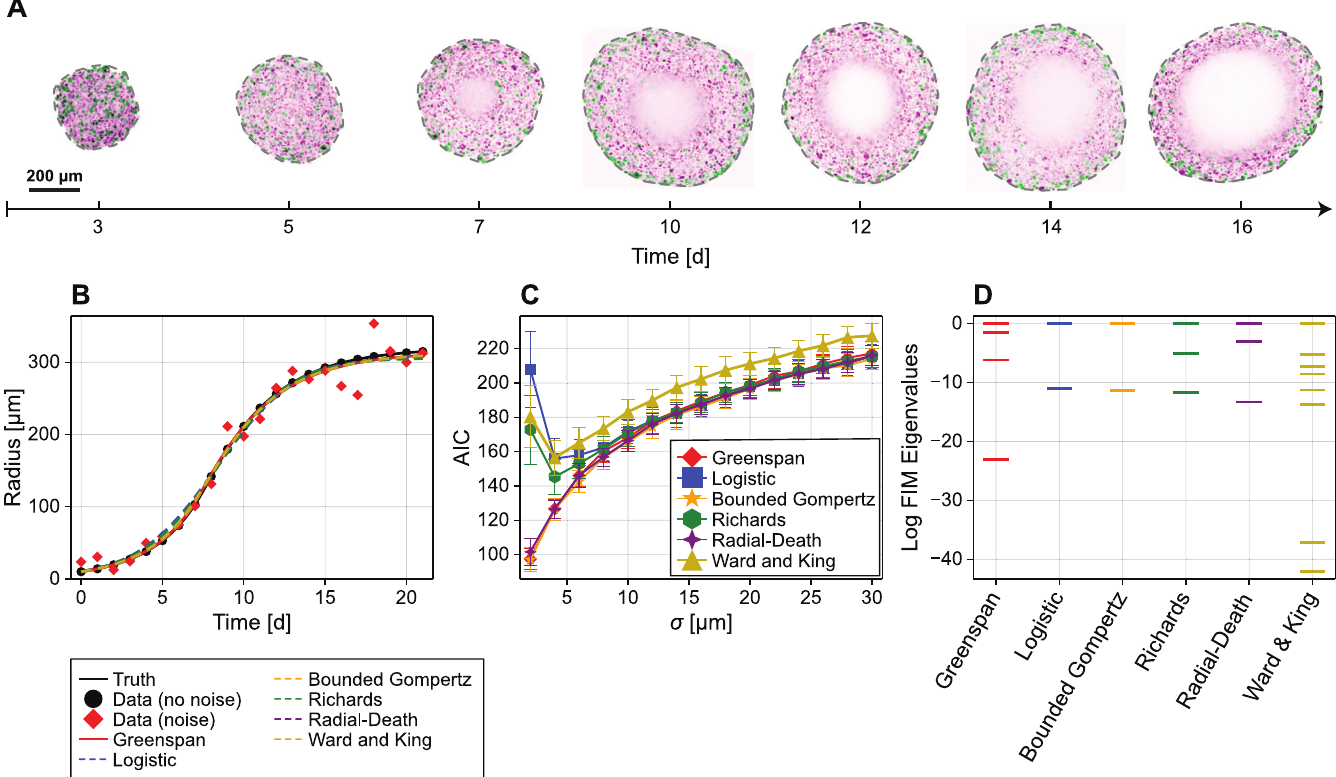
Fig 1. Mathematical models of tumour spheroid growth. (A) Microscopy images from tumour spheroid growth experiments. Spheroids are grown from WM983b cells (a human melanoma cell line) [18], harvested, and imaged using confocal microscopy at various time points. Cells are transduced with fluorescent cell cycle indicators, showing cells in gap 1 (purple) and gap 2 (green). From day 7, a necrotic core void of living cells is evident in the spheroid centre. (B) Synthetic spheroid data generated from Greenspan’s model [13] (black discs) with additive normal noise with standard deviation σ = 20 μ m (red diamonds). (B–C) Several mathematical models, including the Greenspan model, are able to match synthetic data. (C) AIC results for the model fitting exercise in (B) repeated over several values of the noise standard deviation. Shown is the mean and standard deviation from 100 repeats for each model. (D) Spectrum of the observed Fisher information matrix. Eigenvalues are shown on the log-scale and scaled such that the spectral radius is